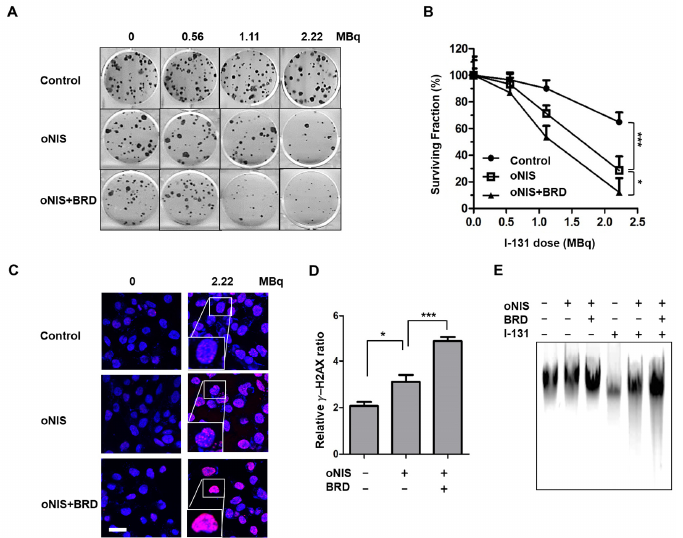
Figure 2. Therapeutic effect according to BRD overexpression in response to I-131 treatment. ( A ) Clonogenic survival assay in control, oNIS-, and oNIS+BRD-expressing cells. Cells were treated with 0, 0.56, 1.11, or 2.22 MBq of liquid I-131 for 7 h, washed, and incubated in 6-well plates for 10 days. ( B ) Quantification of the clonogenic survival assays in control, oNIS, and oNIS+BRD cells. ( C ) Representative fluorescence images of γ -H2AX foci. Cells were immunostained with anti- γ -H2AX (red) and DAPI (blue) after treatment with liquid I-131 (2.22 MBq) after a 7 h incubation. Scale bar = 30 μ m. ( D ) Quantification of the γ -H2AX foci obtained from fluorescence confocal images. ( E ) DNA fragmentation assay with or without 2.22 MBq I-131 treatment. DNA isolated from cells was run on a 1% agarose gel at a current of 100 V for 30 min in TAE buffer. Values are means ± S.E.M. p < 0.001 (***), p < 0.05 (*). 2.2. Overexpression of oNIS and BRG1-BRD Inhibits Tumor Growth In Vivo through I-131- Enhanced Damage Thereafter, we considered using BRG1-BRD as a radiosensitizer during radioiodine treatment and established tumor xenograft models using control, oNIS, and oNIS+BRD cells (Figure S2). To visualize tumor growth in the mouse models, we used reporter-ex- pressing FRO cells. A firefly luciferase gene was transduced into each cell line for biolu- minescence imaging and tested to confirm that the bioluminescent signal correlated with cell numbers (Figure S2C,D). To determine the most efficient therapeutic dose of I-131, we divided the mice into low- (2.22 MBq) and high- (18.5 MBq) dose groups. In the low-dose treatment group, the mice that received oNIS cells had 22.4% smaller tumor volumes than the control group, and the mice that received oNIS+BRD cells had 74.3% smaller tumor volumes than the oNIS group ( p < 0.005) (Figure 3A). In the high-dose treatment group, mice that received oNIS cells had tumors that were 68.7% smaller than those in the control group, while mice that had received oNIS+BRD cells had tumors that were 63.1% smaller than those in mice that received oNIS cells ( p < 0.005) (Figure 3A). The benefit of synergis- tic oNIS+BRD overexpression in the high-dose group was less apparent than in the low- dose group, because oNIS uptakes I-131 more efficiently than hNIS and 18.5 MBq I-131 already causes a dramatic decrease in tumor volume. However, regarding the low-dose mouse model, a combination treatment with BRD induced a similar level of tumor size